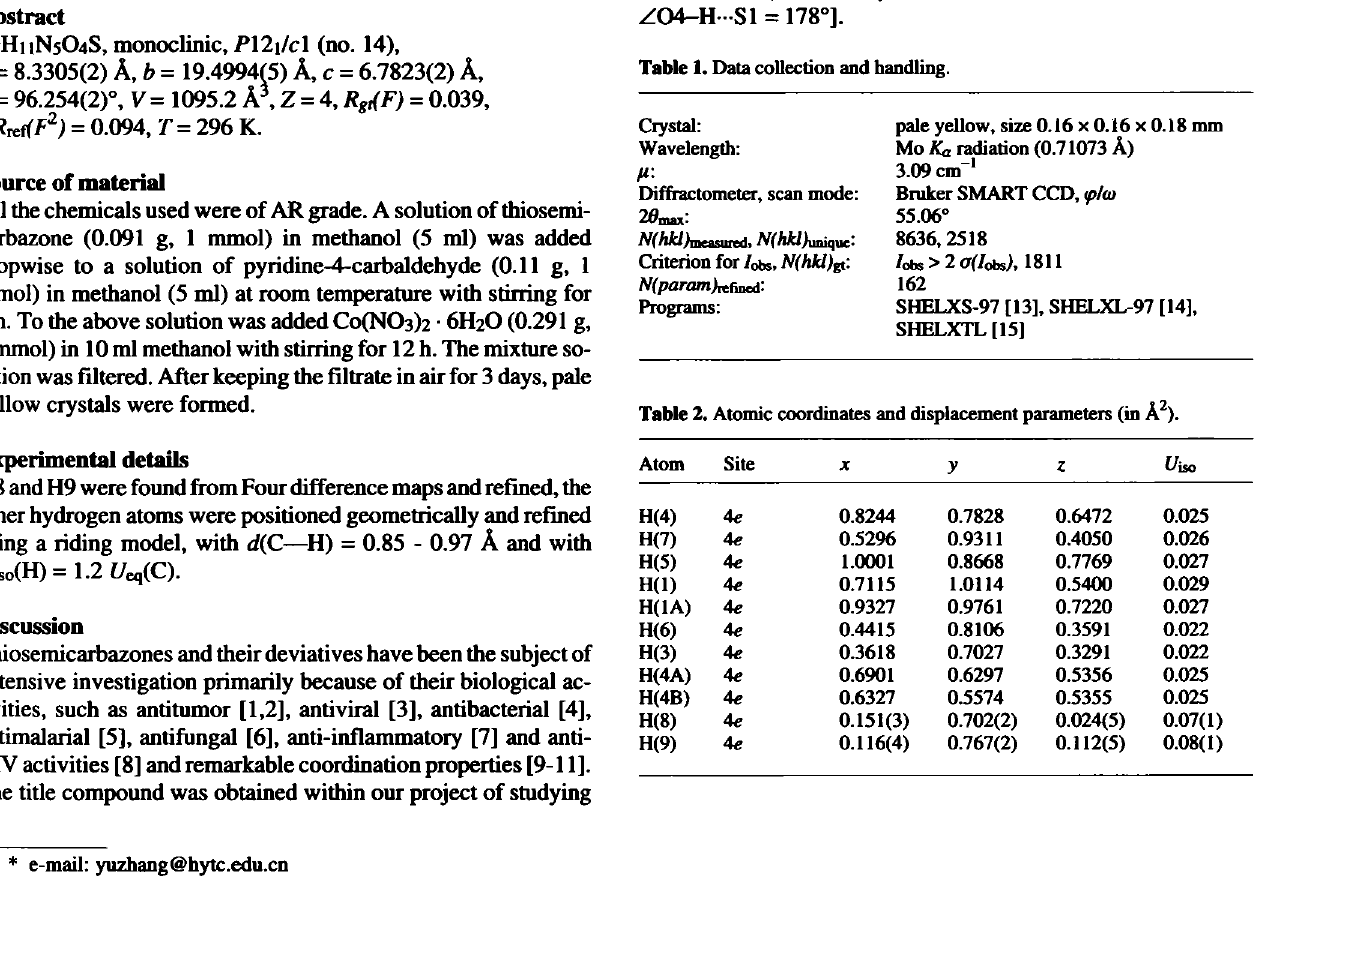
Table 1. Data collection and handling.